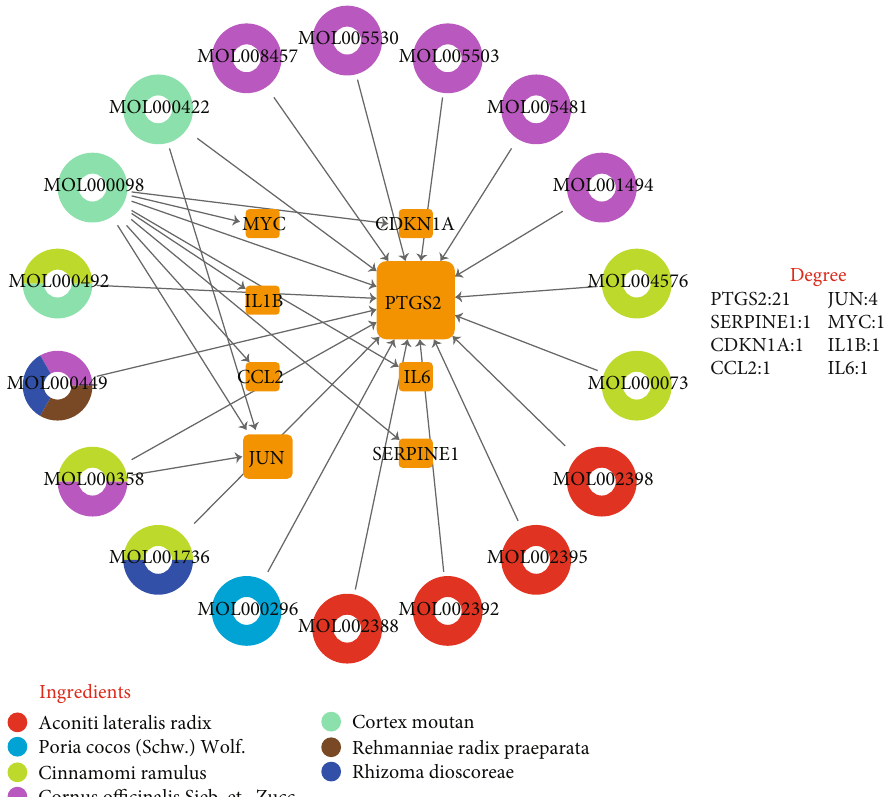
Figure 4: “ Compound-target ” network. The middle yellow squares represent the target genes of SQP; the larger the shape of the gene is, the more active compounds are targeting that gene. The outer circles represent active compounds, and di ff erent colors indicate that the active compound exists in the di ff erent Chinese herbs.